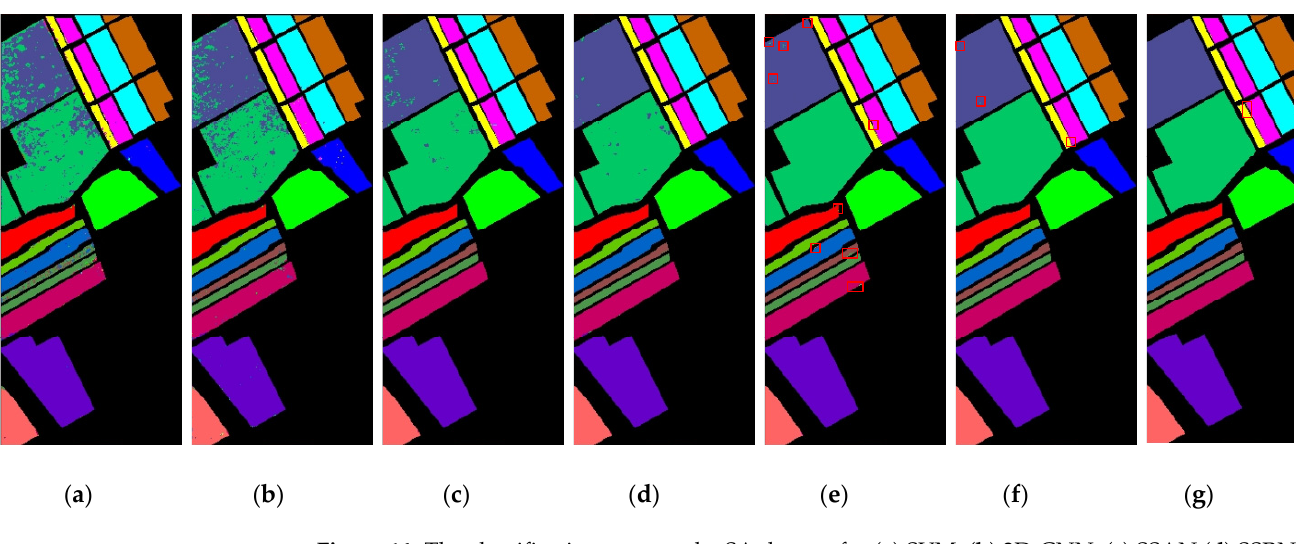
Figure 13. Overall accuracy curve of different models in UP dataset.